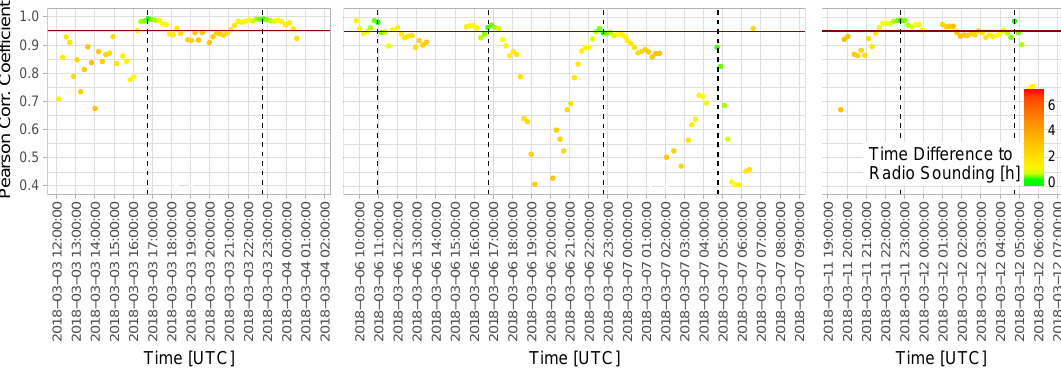
Figure 2. Pearson correlation coefficient between log ( w RS ) and log ( S lidar ) at heights where data would fulfill all other criteria to be selected for calibration ( z i ) during the nights from 3 March 2018 to 4 March 2018, 6 March 2018 to 7 March 2018 and 11 March 2018 to 12 March 2018. Colors indicate the temporal difference between the start of the radiosonde and the lidar measurement. Red line shows the threshold for minimal correlation applied here. Start of radiosounding measurement indicated by black, dashed